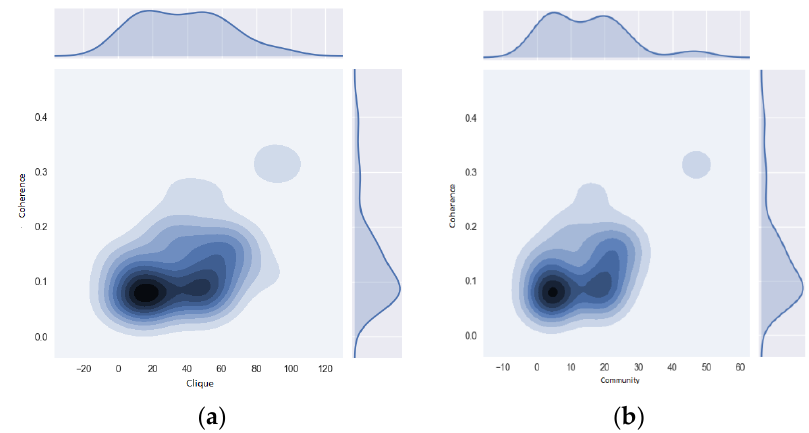
Figure 7. Motif coherence for cliques and communities. Motif coherence for ( a ) cliques and for ( b ) communities for the Morbidity Network of Diagnoses of the victims of the armed conflict in Colombia, residing in the Risaralda province , from 2011 to 2016. Source: authors’ own calculations.